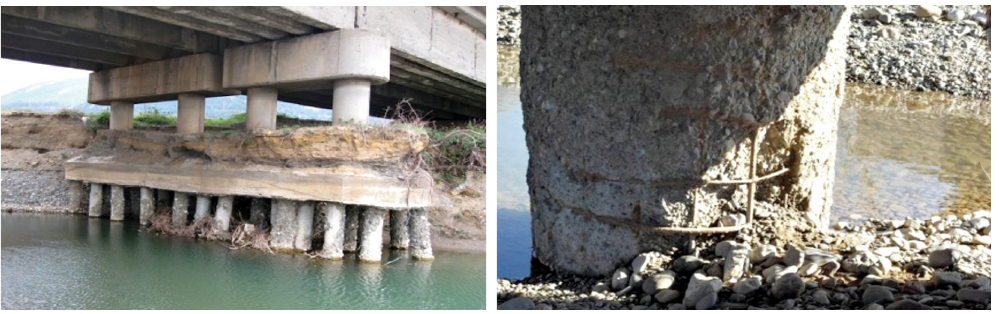
(a) Heavy scour (b) Exposed steel Figure 5. Scour problems in Mat bridge